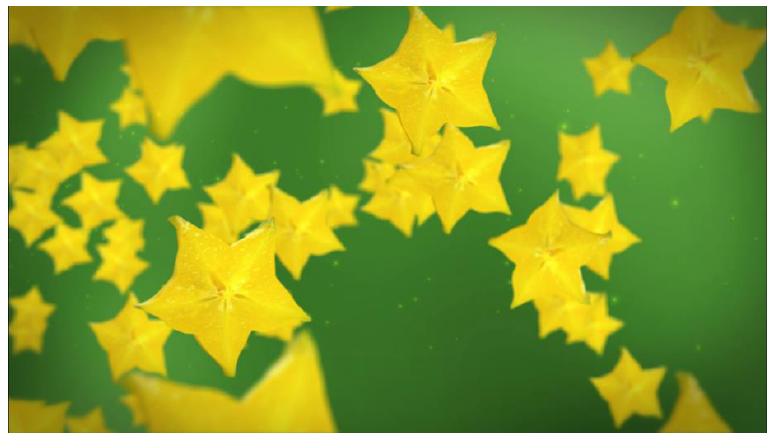
Figure 4. Kerry Tribe, still from The Aphasia Poetry Club (2015), three-channel video with sound, 28:27 min.